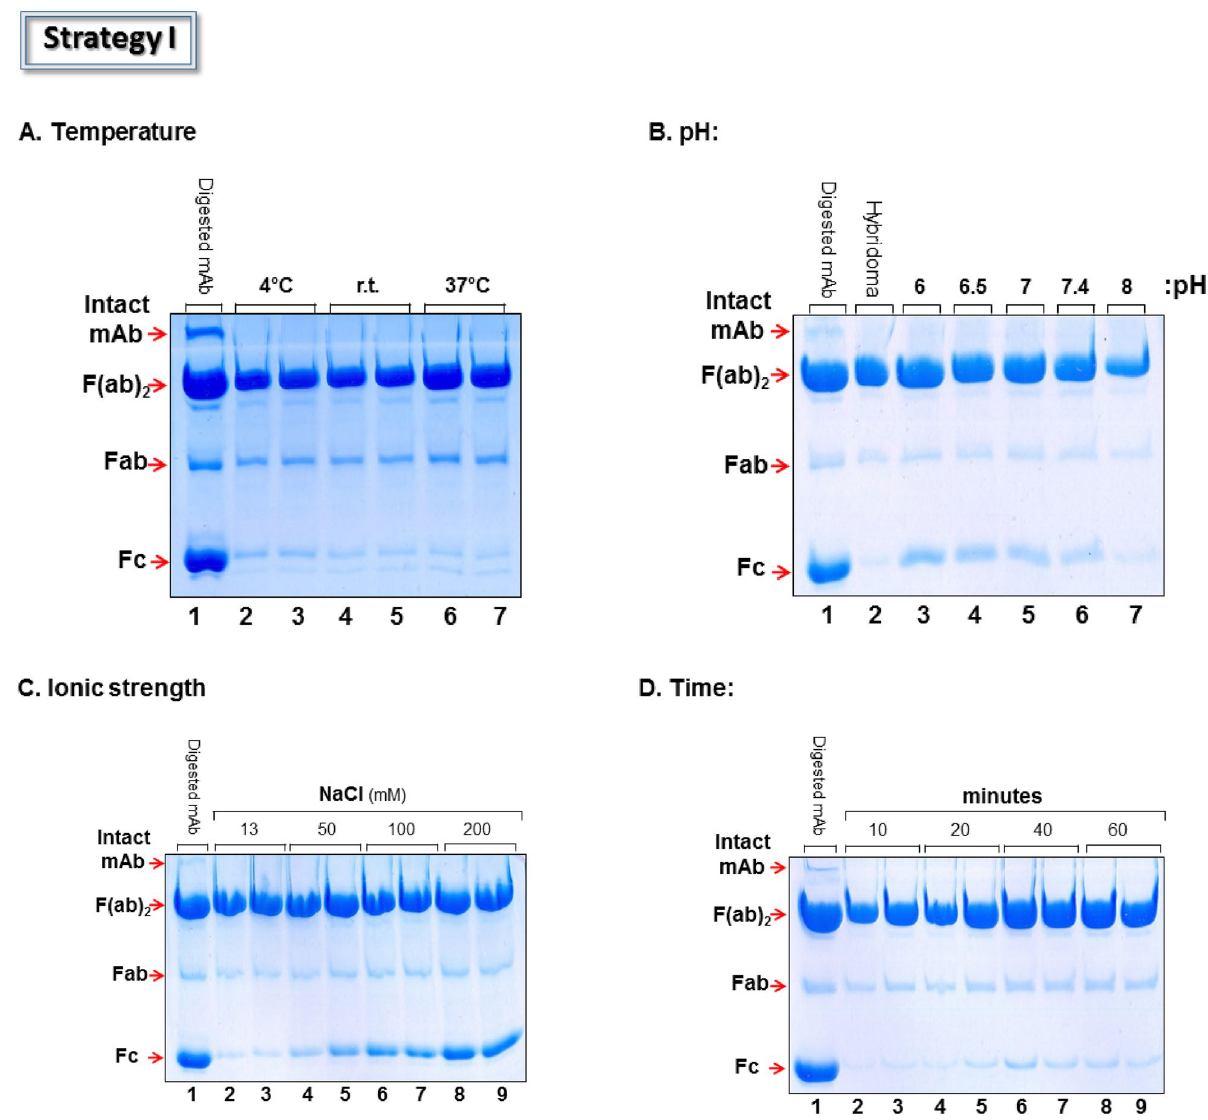
Figure 3. Parameters affecting strategy I. ( A ) Effect of temperature on the binding of Ab-fragments to Brij S-100 aggregates. Samples represent the supernatant composition after brief incubation (10 min.) with the detergent aggregates. ( B ) As in A, but at pH values indicated. ( C ) As in A, but at salt concentrations indicated. ( D ) As in A, but at pH 7.4, 13 mM NaCl and indicated time points. Gels are Coomassie stained. E. coli lysate was not